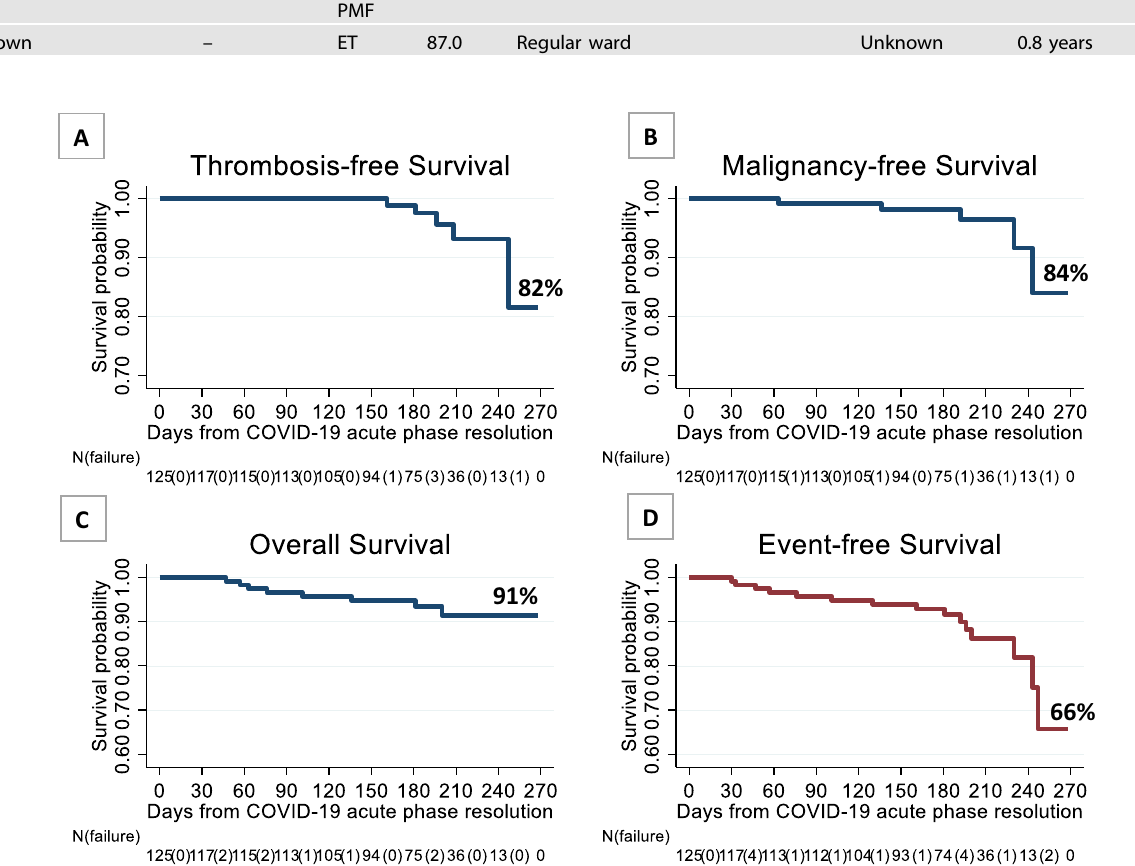
Fig. 1 Major outcomes at 6-months follow-up after COVID-19 recovery. Kaplan – Meier survival estimates from COVID-19 recovery of ( A ) Thrombosis-free, ( B ) Malignancy-free, ( C ) Overall survival and ( D ) Event-free